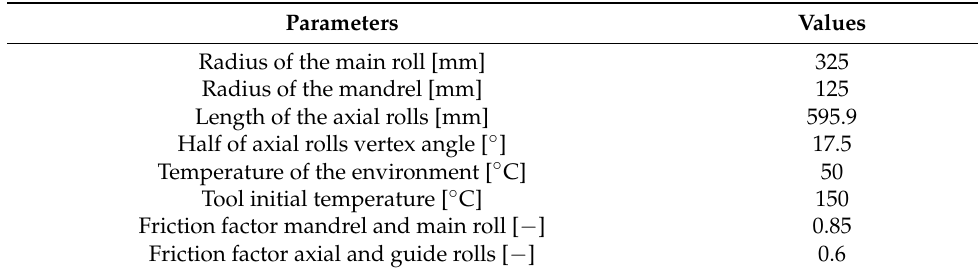
Figure 1. Configuration of the ring rolling process. Table 1. Ring rolling mill characteristics and general process